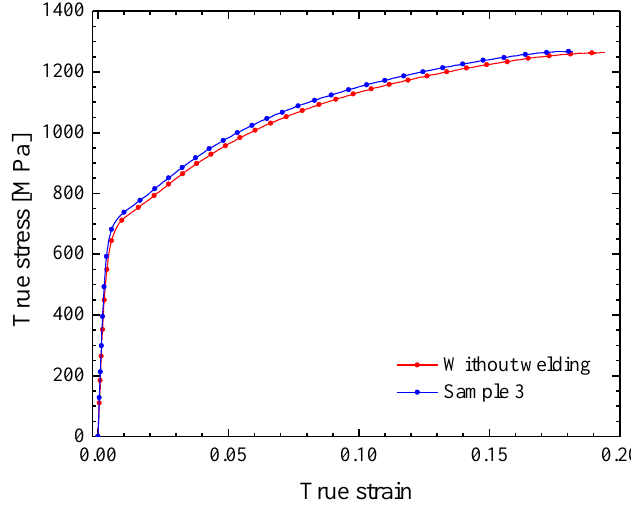
Figure 6. True stress vs. strain curve for Gen3 980T steel, with and without weld.